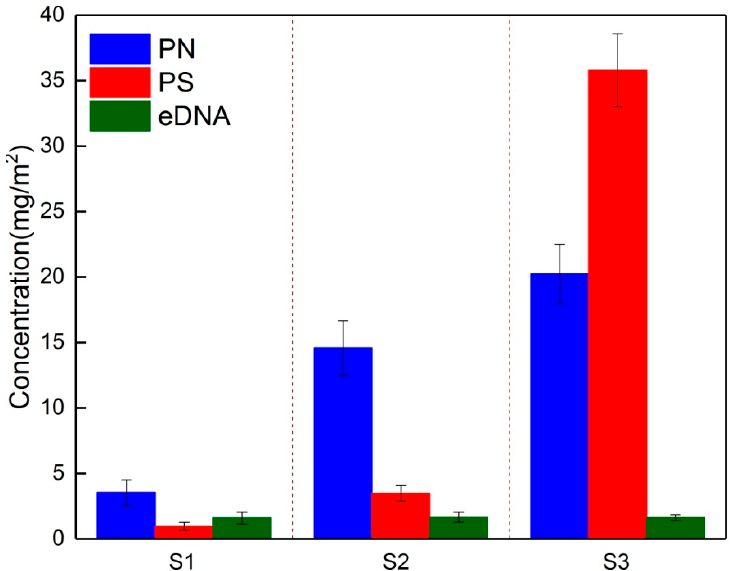
Figure 3. Variations of extracellular polymeric substances (EPS) composition in the biofouling layer on the membrane surfaces. PN = proteins; PS = polysaccharides; eDNA = extracellular DNA.